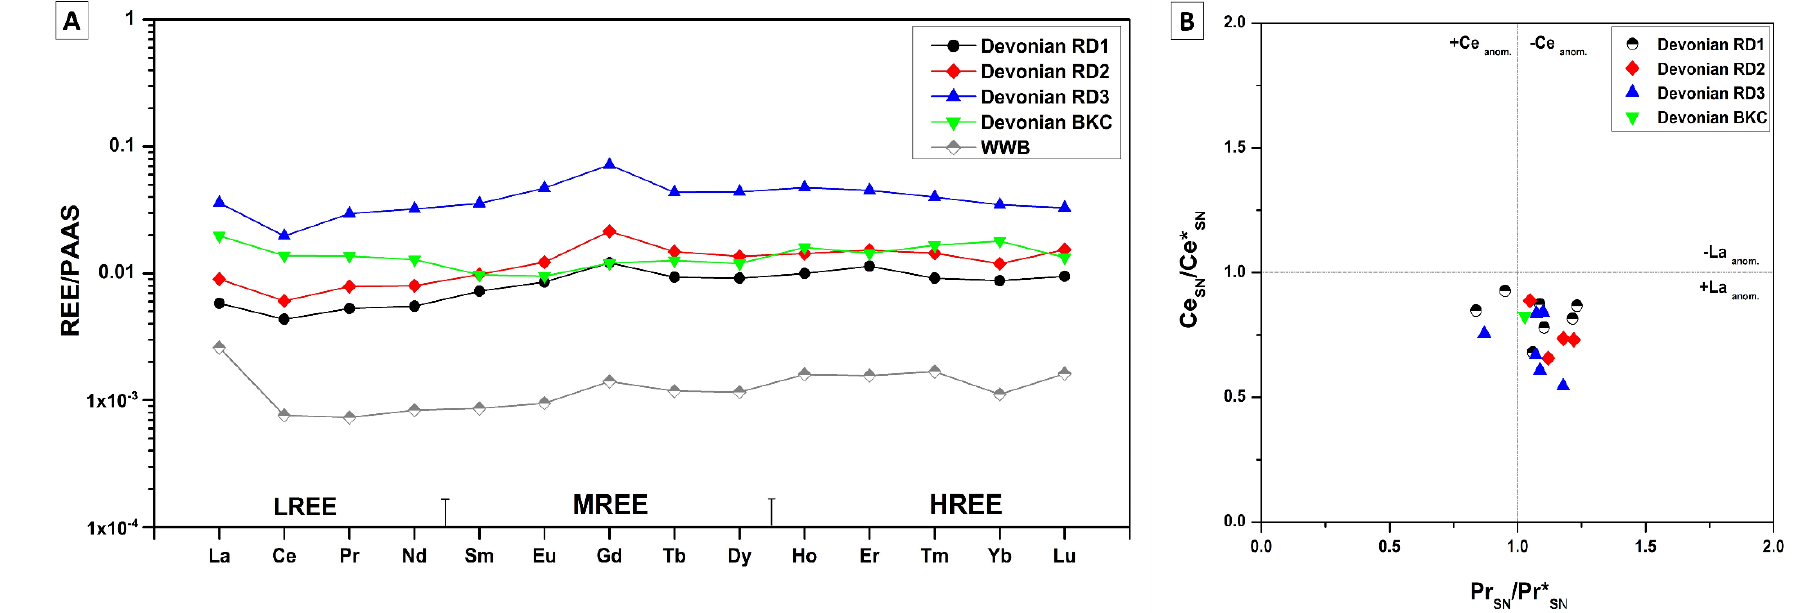
Figure 18. ( A ) PAAS normalized REE pattern for average values of fine (RD1) and medium (RD2) crystalline dolomite, dissolution seams dolomite (RD3) and fracture-filling calcite (BKC) samples, compared with average PAAS normalized REE pattern of modern warm water brachiopods [54]. ( B ) Ce (Ce / Ce*) SN –La (Pr / Pr*) SN anomaly cross plot of RD1, RD2, RD3 and BKC samples.